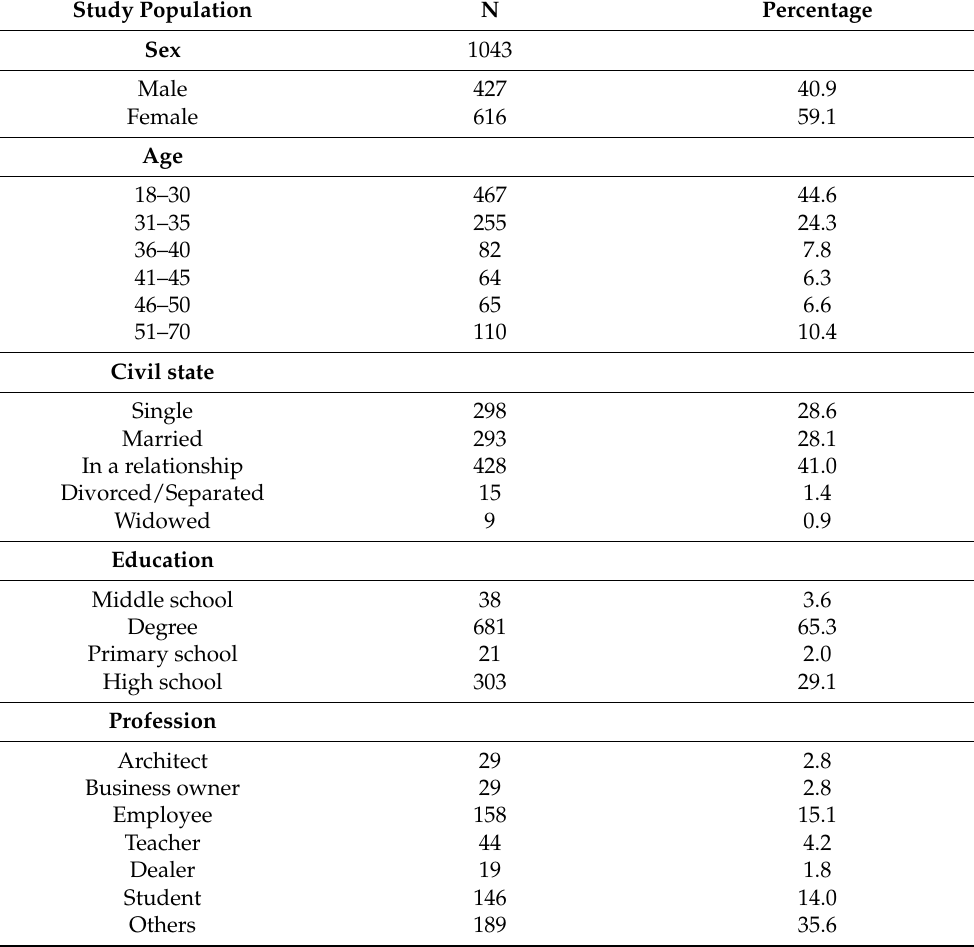
Table 1. Study population